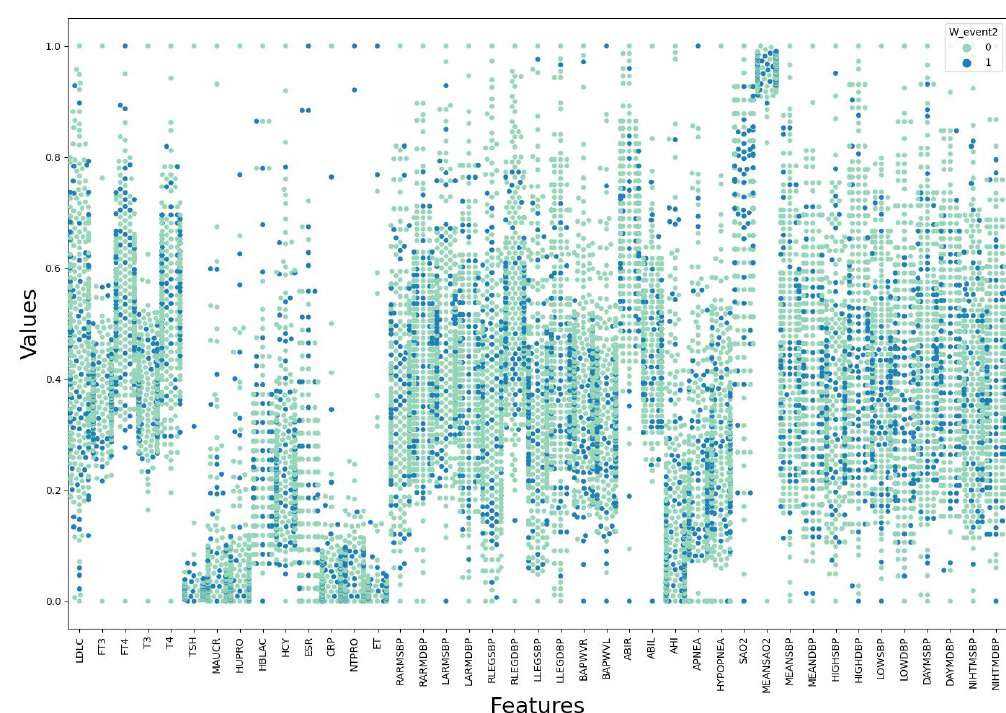
Figure 10. Clustered scatter plot of medical data after preprocessing.